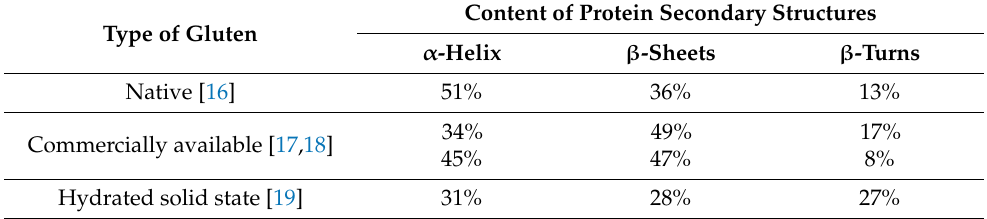
Table 1. Contents of particular secondary structures in different types of wheat gluten determined with application of infrared